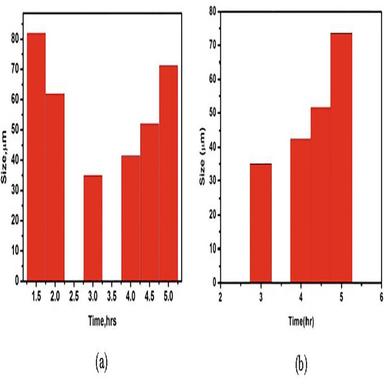
(a) PSD data by DLS technique, (b) Average particle size by SEM Image J analysis.